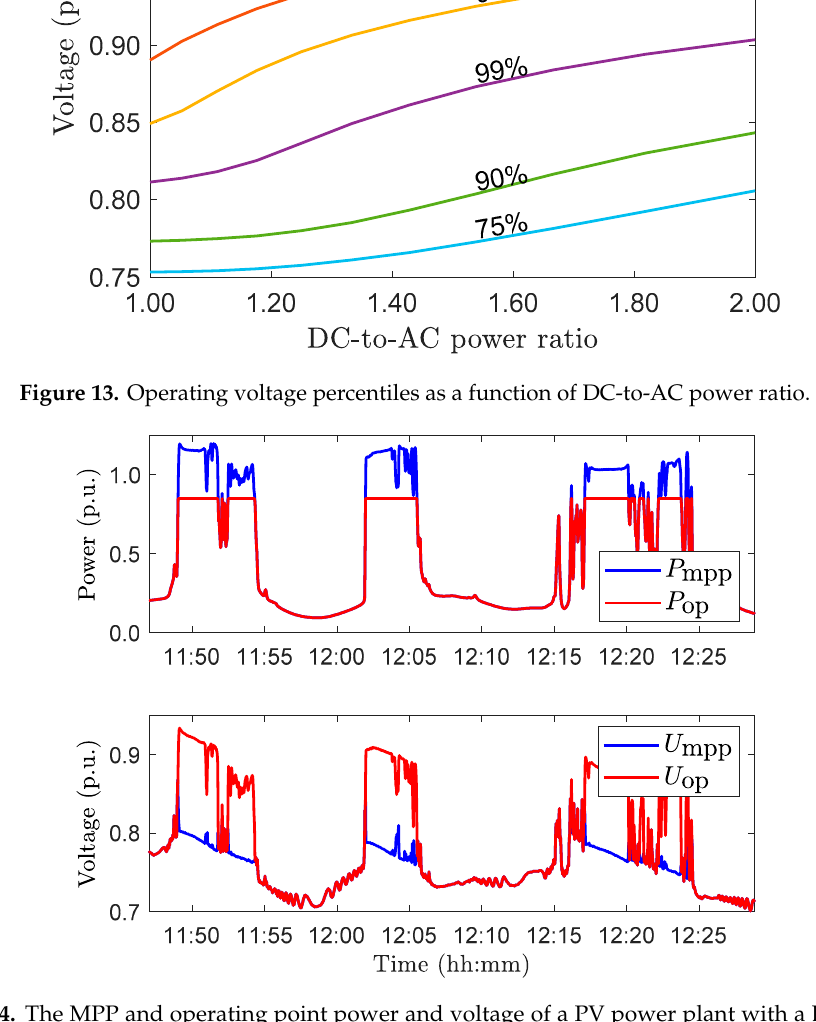
Figure 14. The MPP and operating point power and voltage of a PV power plant with a DC-to-AC power ratio of 1.2 during a partly cloudy period.